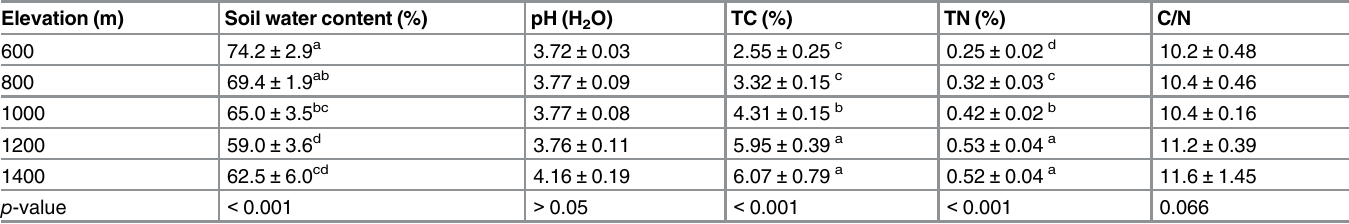
Table 1. Soil water content, pH, total carbon (TC) and total nitrogen (TN), and C:N ratio (C/N) in surface soil (0 – 10 cm) in 5 moso bamboo planta- tions along an elevation gradient. Elevation